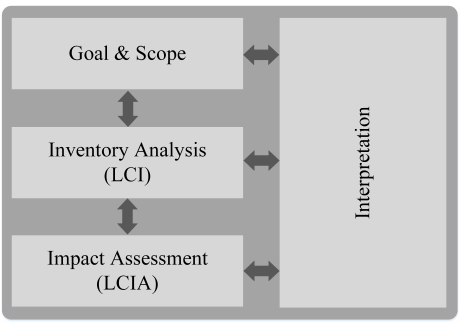
Figure 1. Life cycle assessment (LCA) steps according to ISO 14040, 14044, and